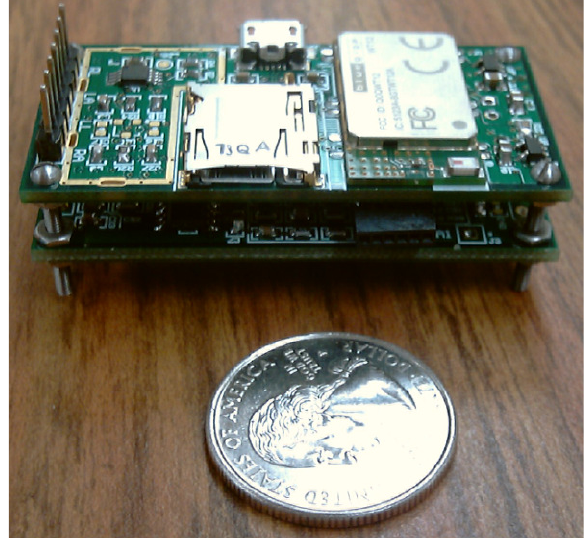
Figure 2. One sensor node in iBoSen.